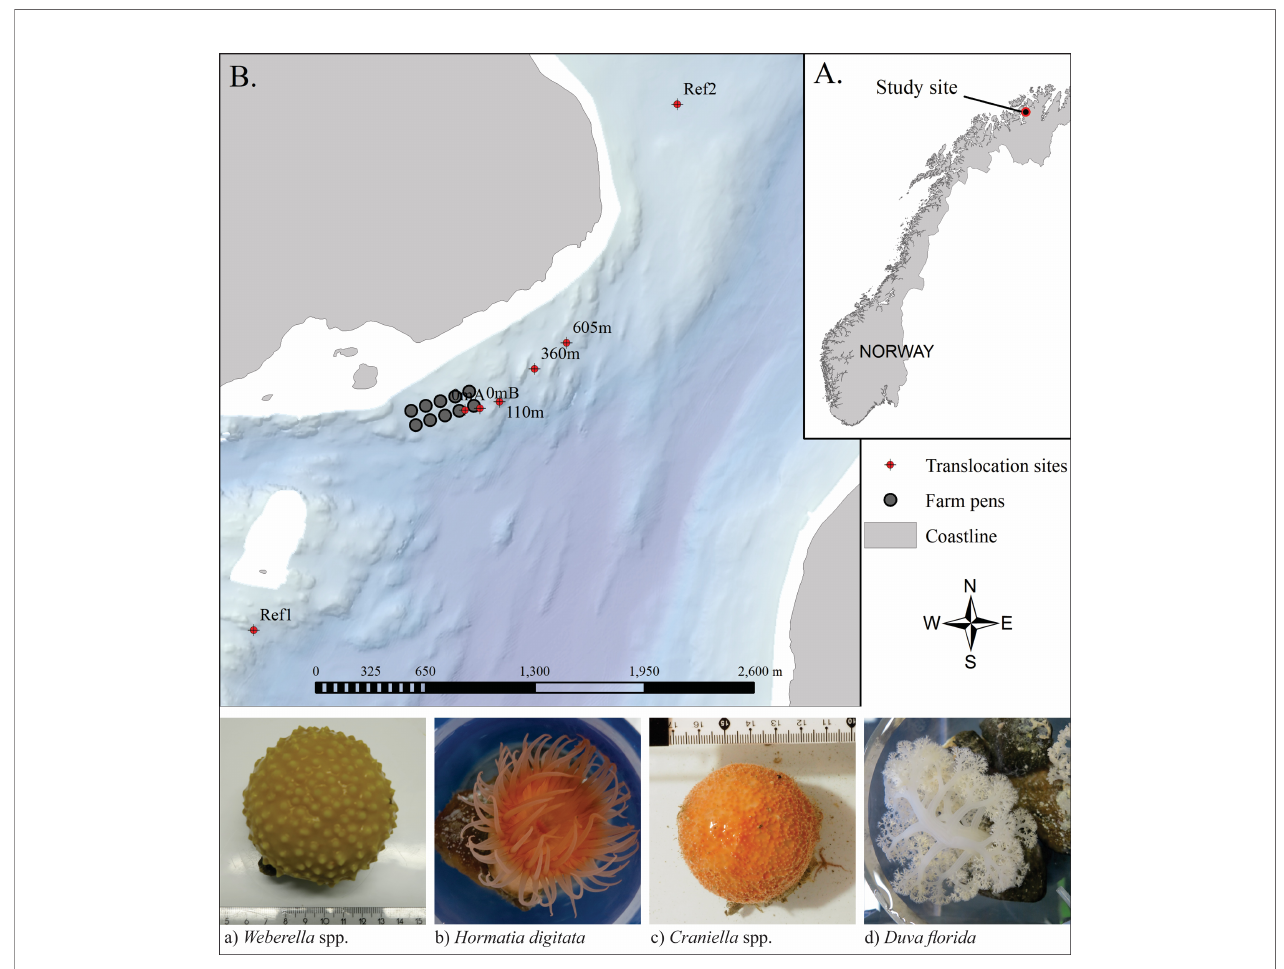
FIGURE 1 | Study site in Vargsundet, northern Norway (A) with arrangement of the seven translocation rigs in relation to the fi sh farm (B) , and below, example photos of the four selected species, taken before being transferred to the grow-out